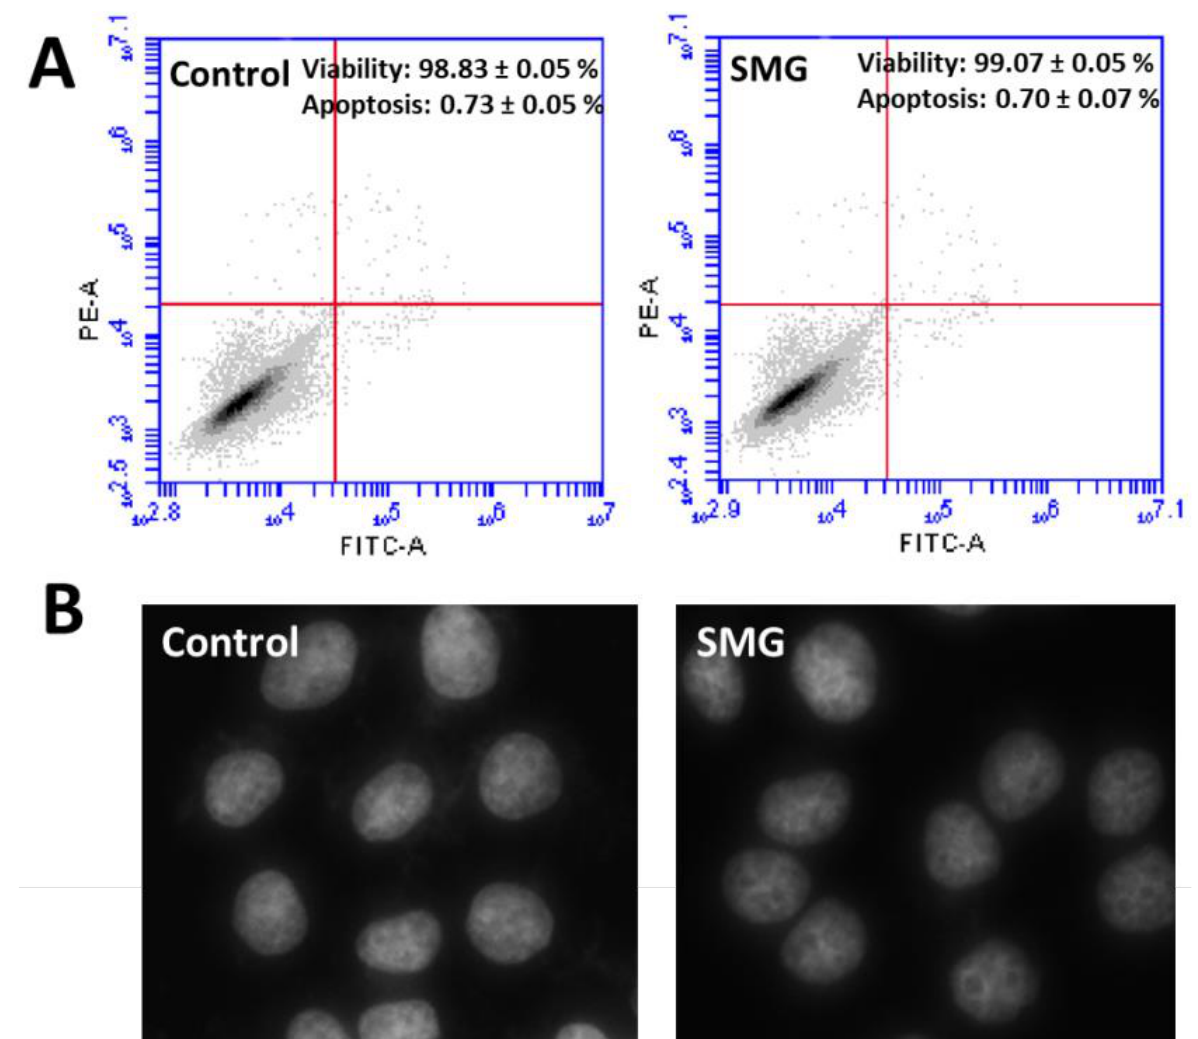
Figure 3. The apoptosis and viability of CCL-13 cells. ( A ) Flow cytometry analysis of apoptosis and viability in CCL-13 cells ( n = 4). ( B ) Nuclear morphology of CCL-13 cells.